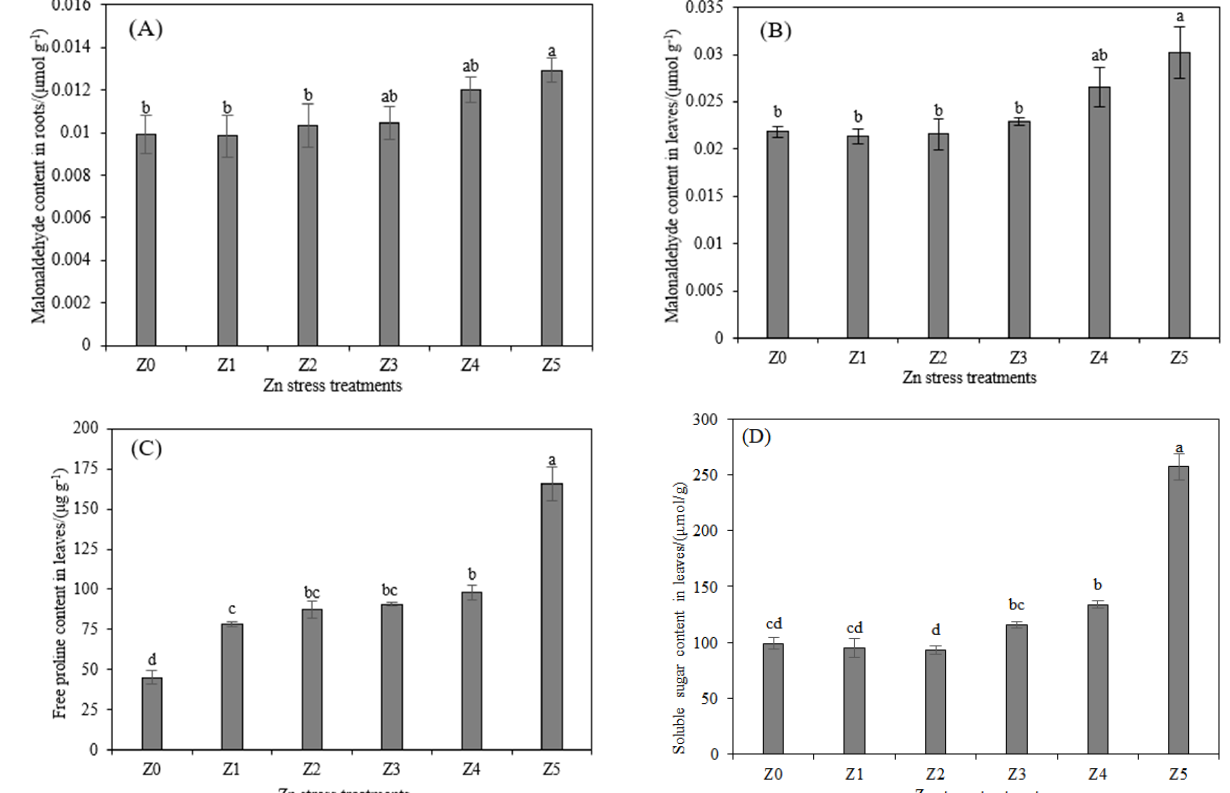
Figure 1. Impacts of different Zn treatments on malonaldehyde content in roots ( A ), malonaldehyde content in leaves ( B ), free proline content in leaves ( C ) and soluble sugar content in leaves ( D ). Along the x ‐ axis of each graph, Z0, Z1, Z2, Z3, Z4 and Z5 indicate that the Zn concentrations are 0 (or control), 75, 150, 300, 600 and 1000 mg/L, respectively. Vertical bars represent the standard errors of the mean ( n = 3). Different letters indicate significant differences among treatments with different Zn concentrations ( p < 0.05).